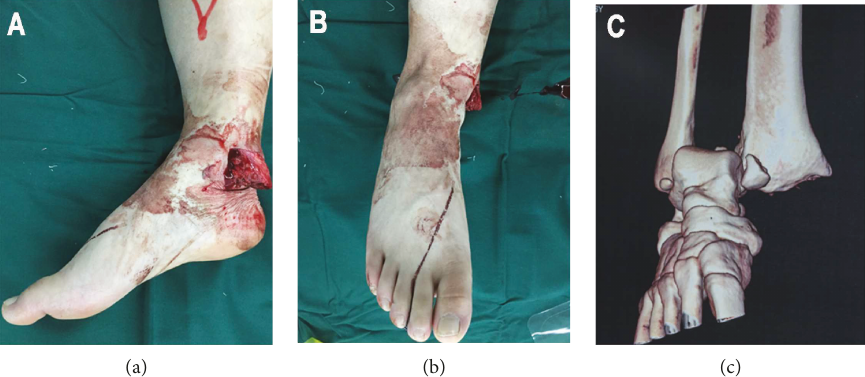
Figure 1: Prereduction view and CT 3D reconstruction of the ankle fracture. (a) Lateral view of the injured ankle. Note displaced distal tibia.